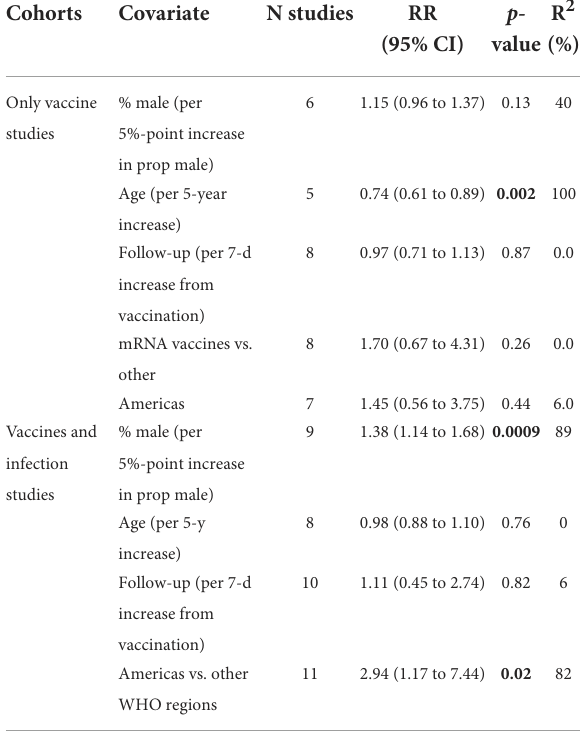
TABLE 2 Results of meta-regression